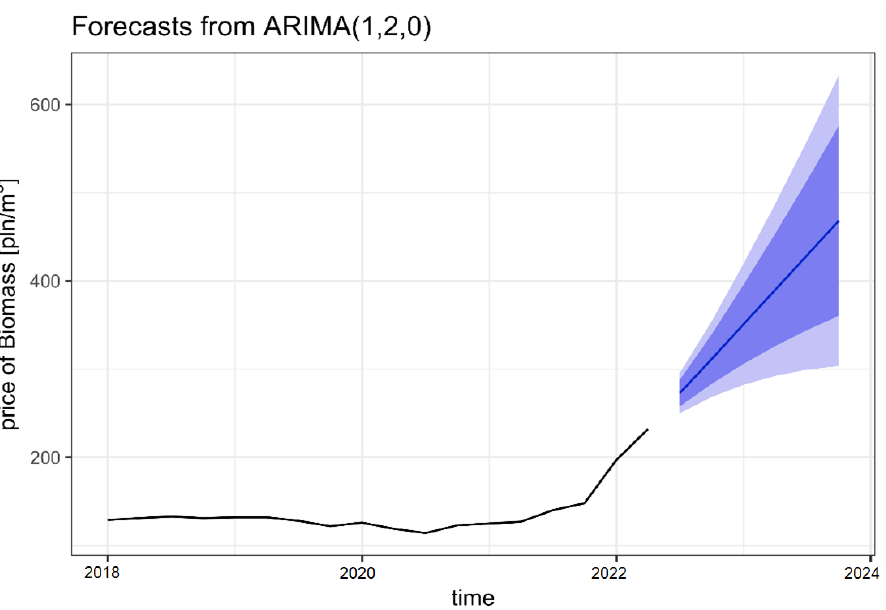
Figure 7. Price forecast for the S2AP assortment for Q3 of 2022, Q4 of 2022, and Q1 of 2023. Source: Own elaboration based on data obtained from the State Forests IT System (SILP).